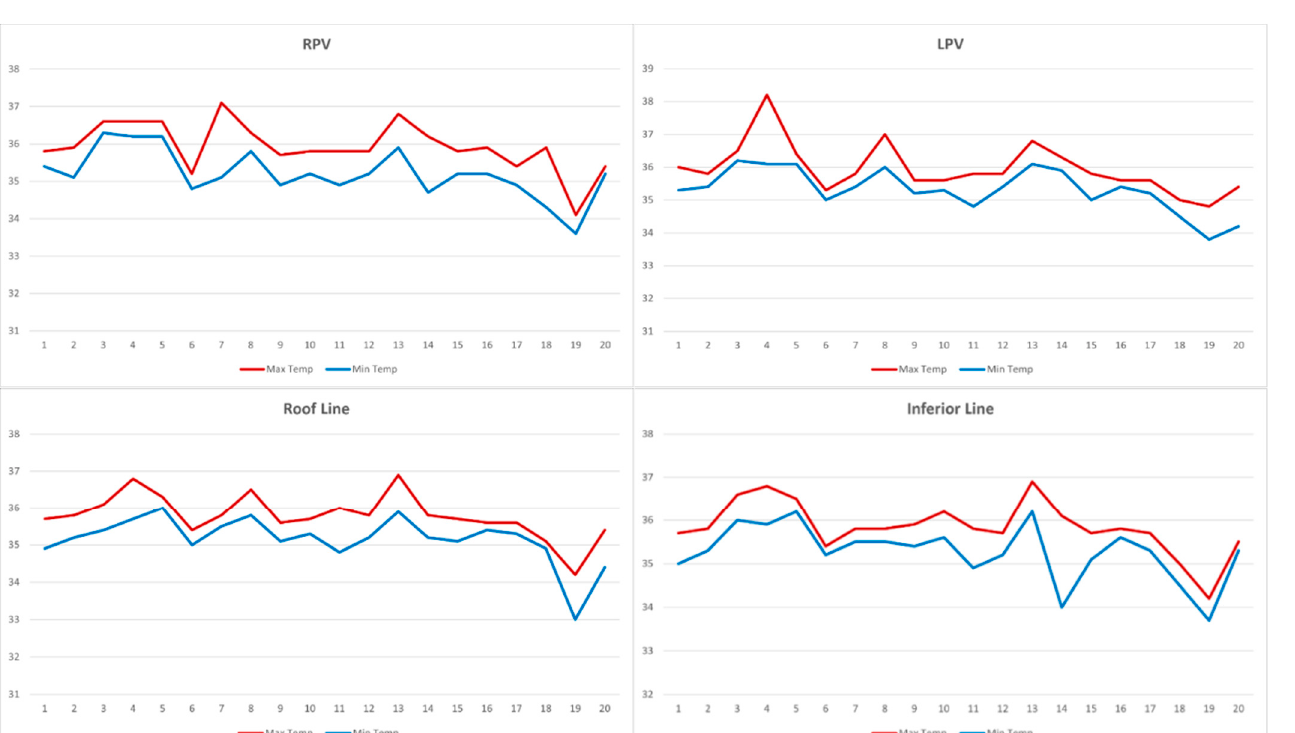
Abbreviations: RPV: right pulmonary vein; LPV: left pulmonary vein.